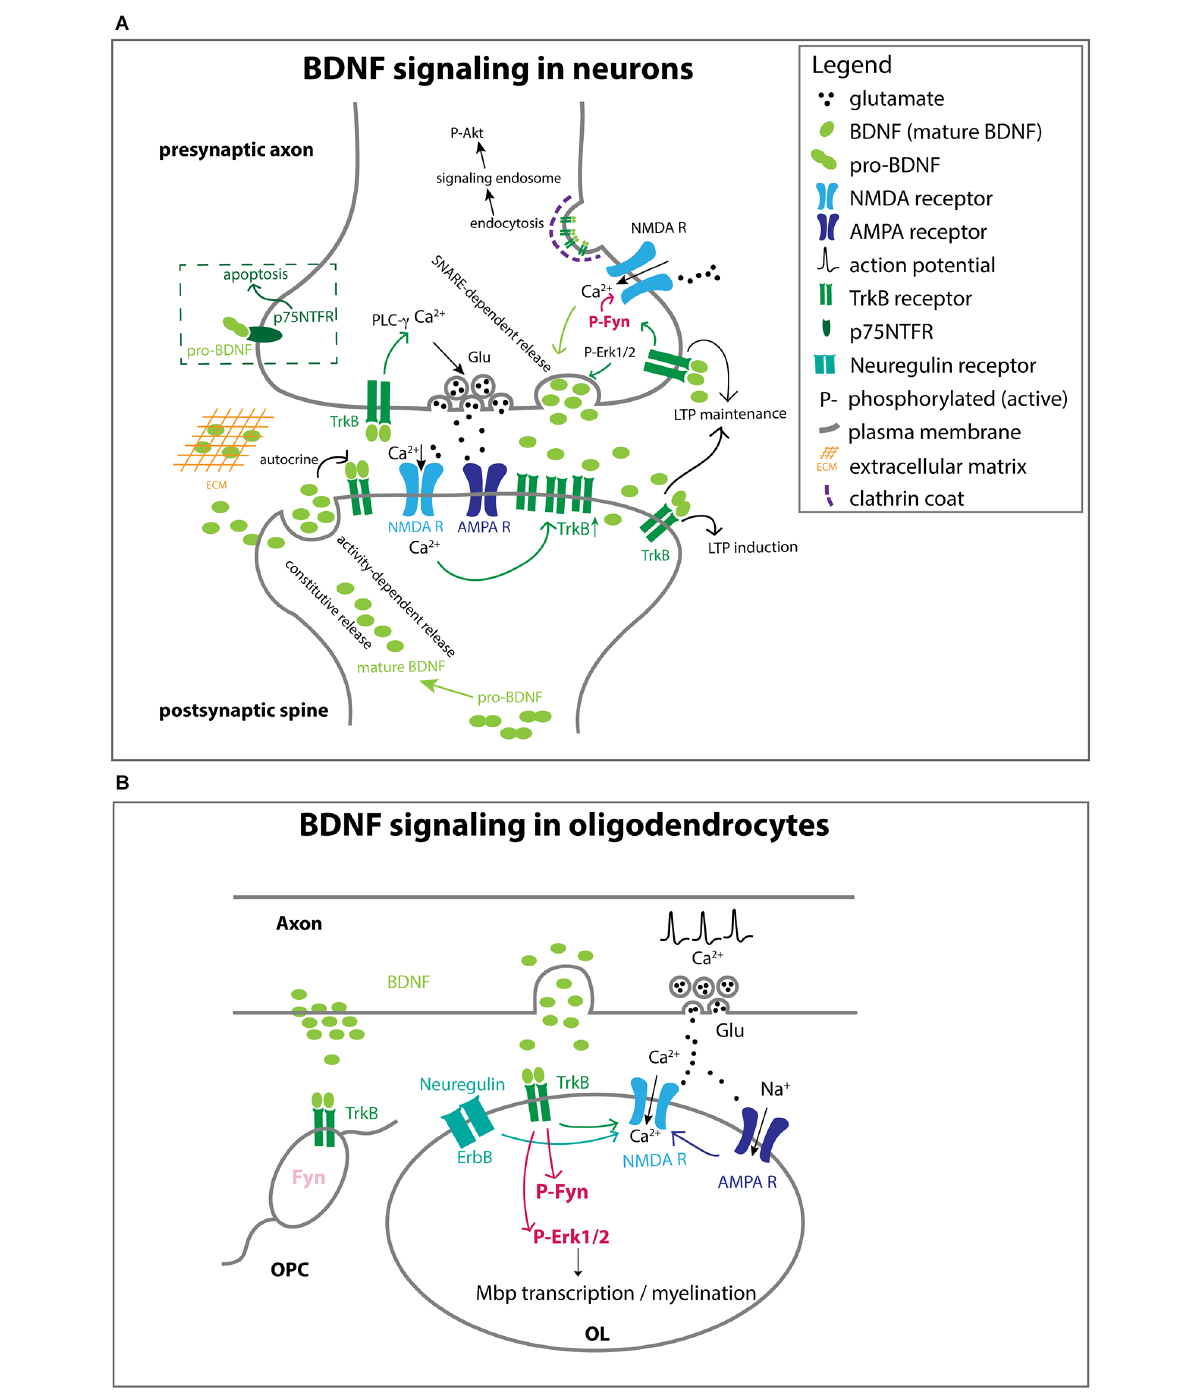
FIGURE3 Different ways in which BDNF acts on cells (A) . BDNF-TrkB function at the neuronal synapse. BDNF from the target neuron or other cells in the target area mediates the survival and axon growth of the presynaptic neuron. Some of the effect is local, while other effects may be mediated by clathrin-dependent endocytosis of BDNF-TrkB complex that could be transported retrogradely by signaling endosomes, analogous to what has been reported for NGF and its high-affinity receptor TrkA. Mature BDNF can be secreted constitutively or in a regulated manner via SNARE- dependent mechanisms. BDNF may not be immediately available to the receptor if it becomes embedded in the extracellular matrix. While the majority of the effects are mediated by mature BDNF, pro-BDNF can also be secreted and act on p75NTFR to elicit a cell death response. BDNF acting on presynaptic and postsynaptic membranes can promote LTP. At the presynaptic terminal, axon depolarizations increase Ca 2 + entry